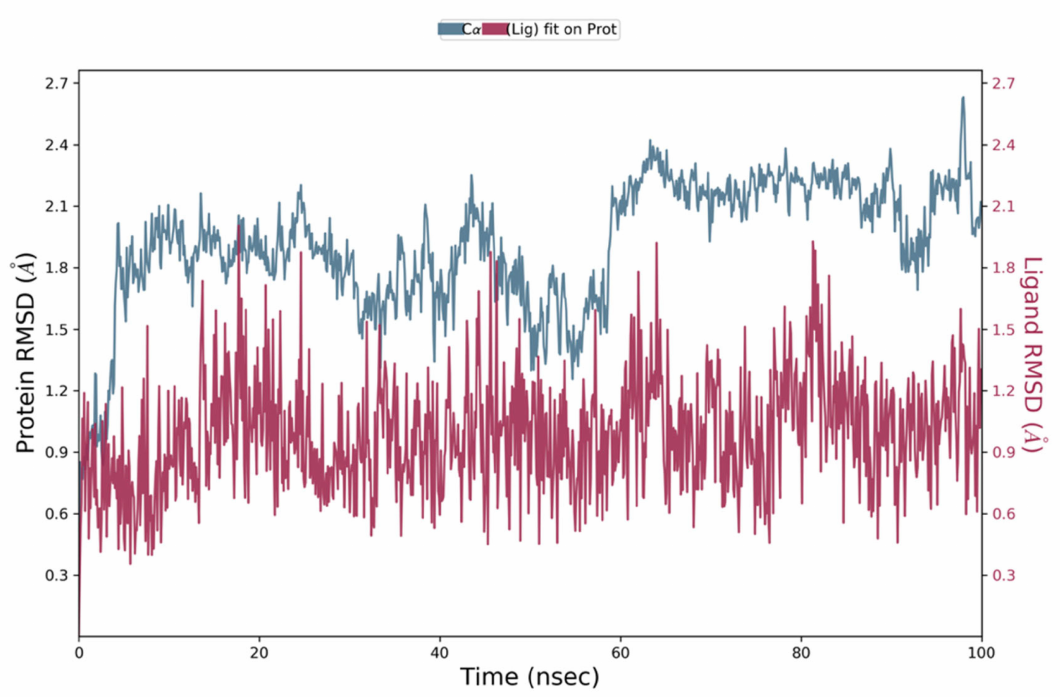
Figure 6. Representation of Root Mean Square Deviation plot of Comp2 and NS2B-NS3 complex of